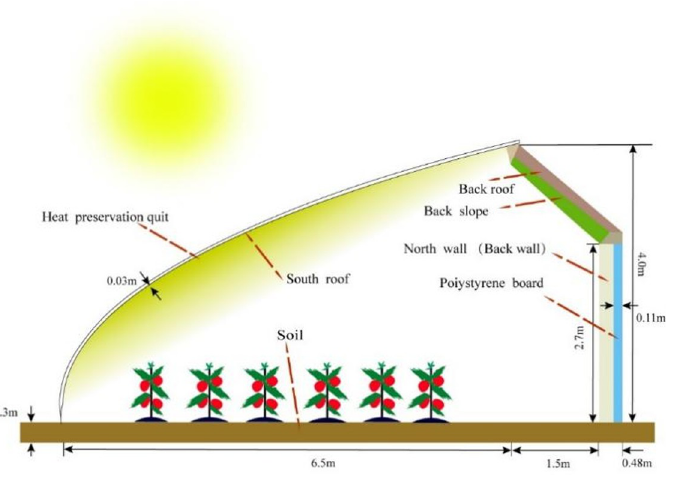
Fig 2. Schematic diagram of the Chinese solar